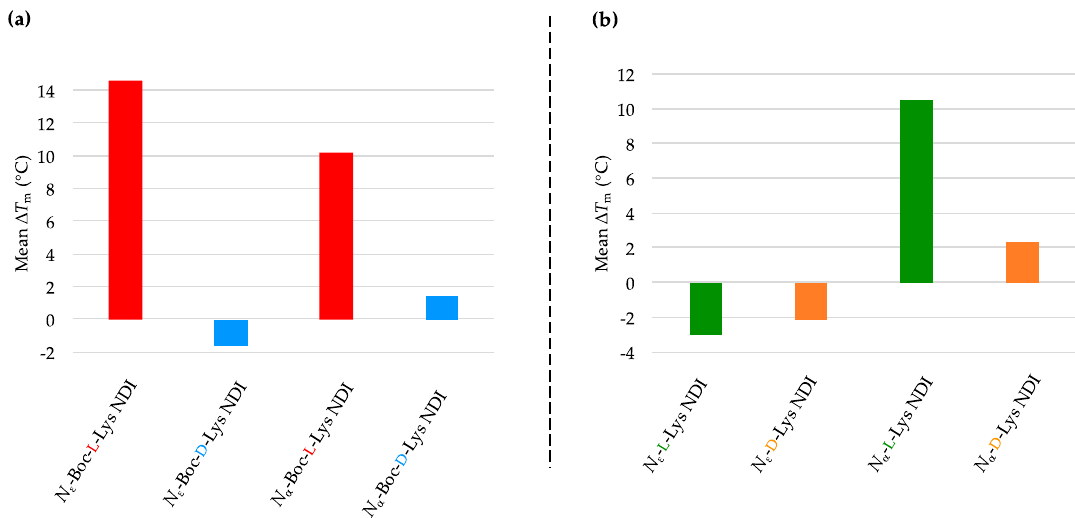
Figure 3. Graphical representations of mean Δ T m values obtained from variable-temperature circular dichroism (VT CD) studies of c-KIT2 with 10 equivalents of ( a ) N α - and N ε -Boc- L - and D -NDIs as well as ( b ) N α - and N ε - L - and D -NDIs. Table 1. The T m values of c-KIT2 only compared to the T m of ( a ) c-KIT2-Boc-protected-NDIs and ( b ) c-KIT2-deprotected-NDIs as determined from VT CD studies.